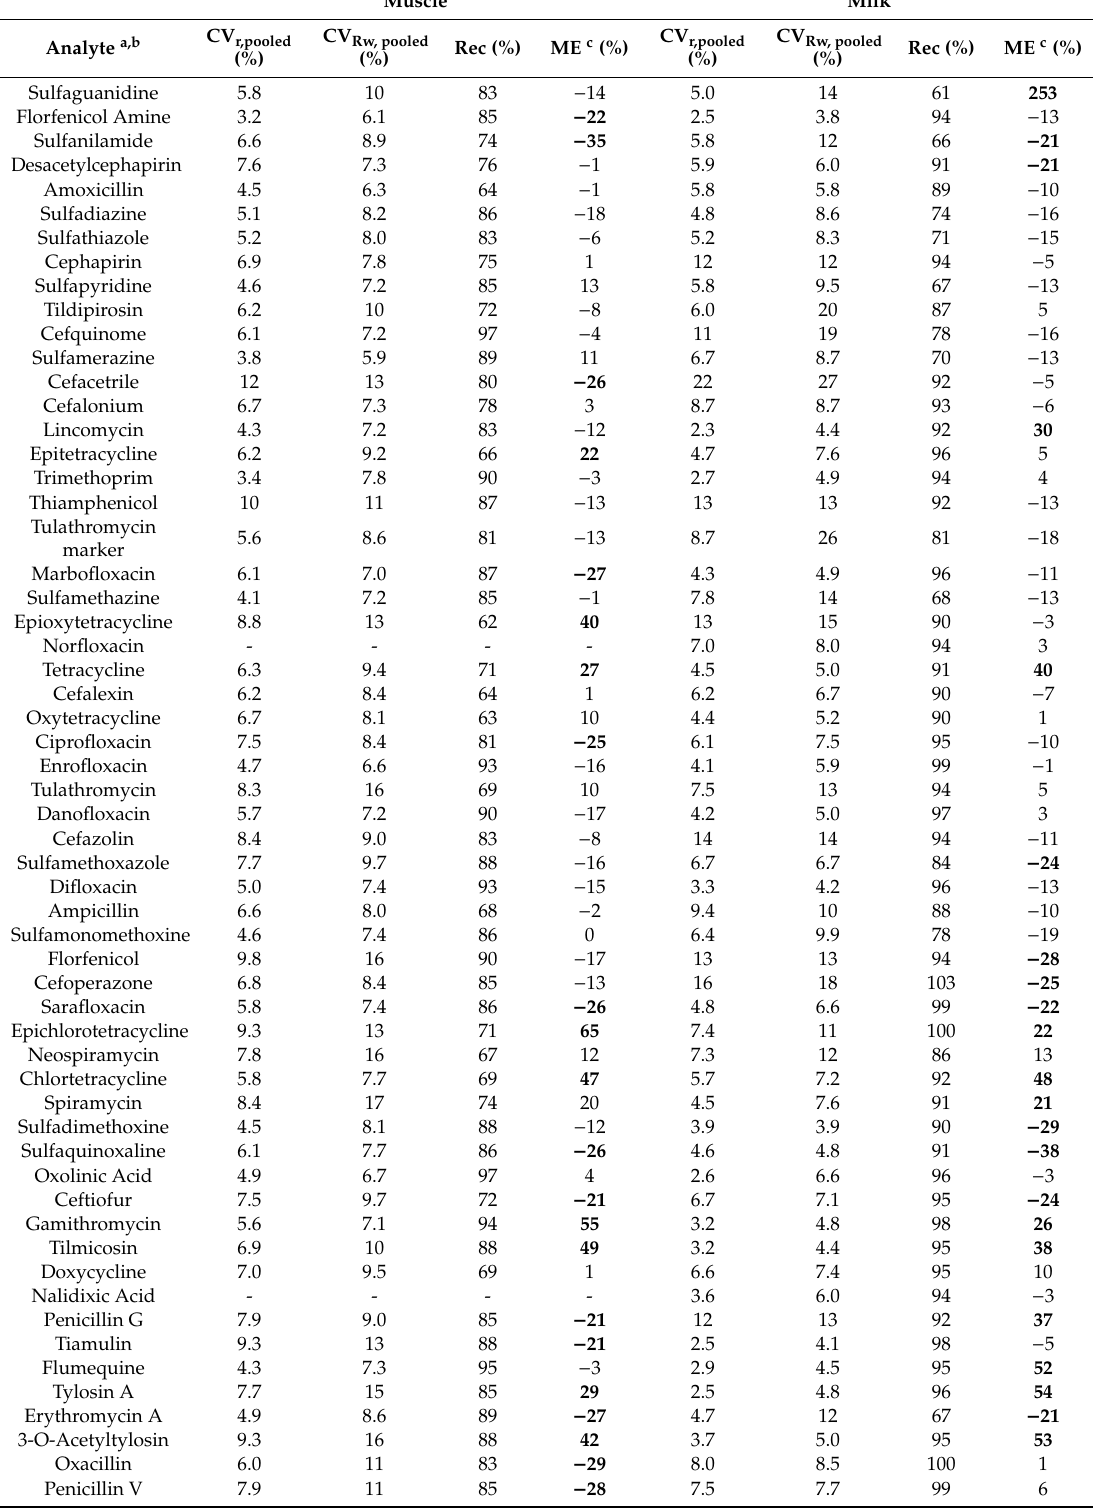
Table 3. Precision, recovery and matrix e ff ect (muscle and milk).